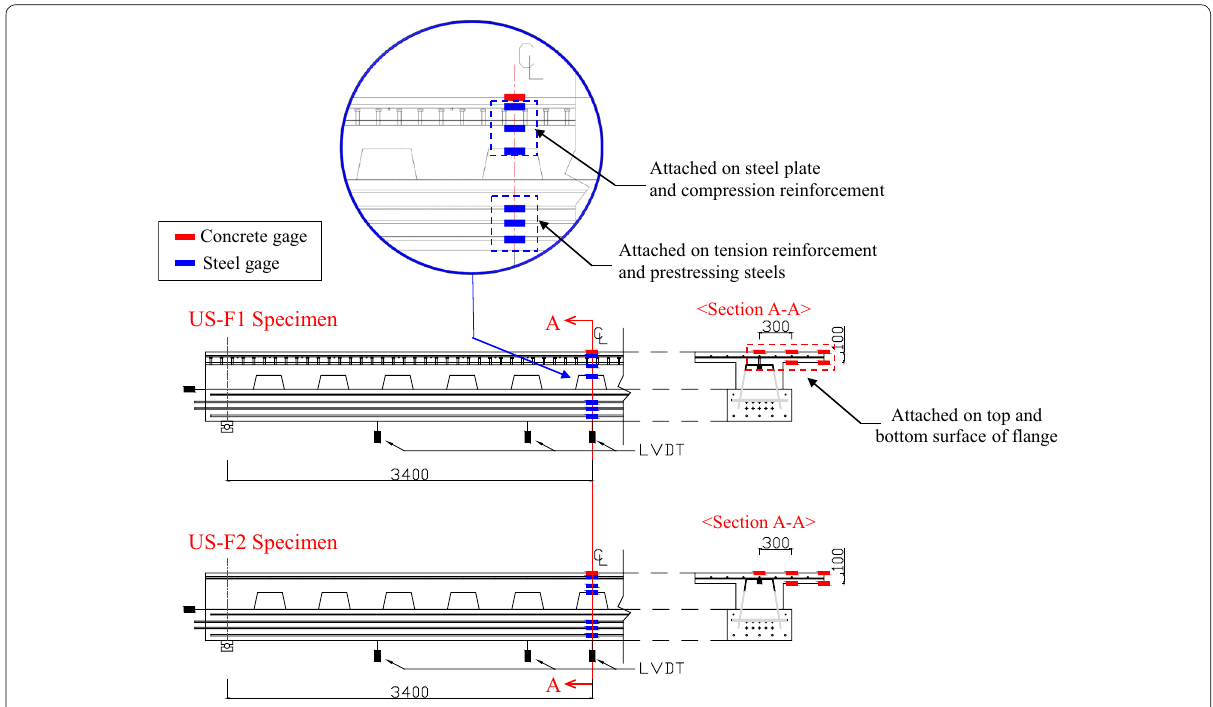
Fig. 5 Details of strain gages and measuring devices (unit: mm).